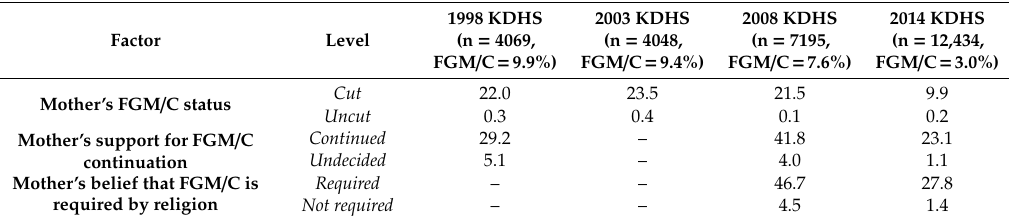
Table 1. National prevalence and girl’s female genital mutilation / cutting (FGM / C) prevalence by normative influence variables across the four selected Demographic and Health Surveys (DHS) surveys in Kenya, Kenya Demographic and Health Surveys (KDHS) 1998 to 2014.